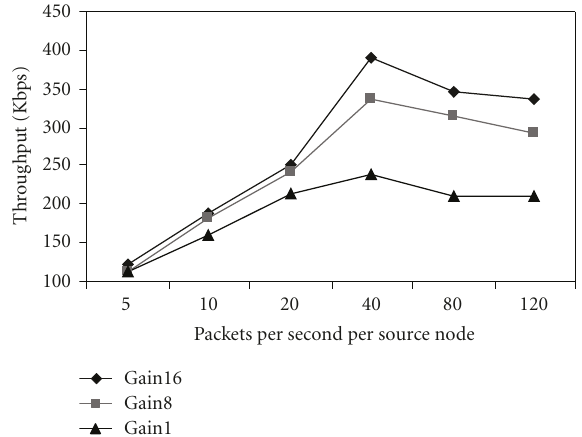
Figure 25: Throughput of DMAC-DACA with di ff erent antenna gains.